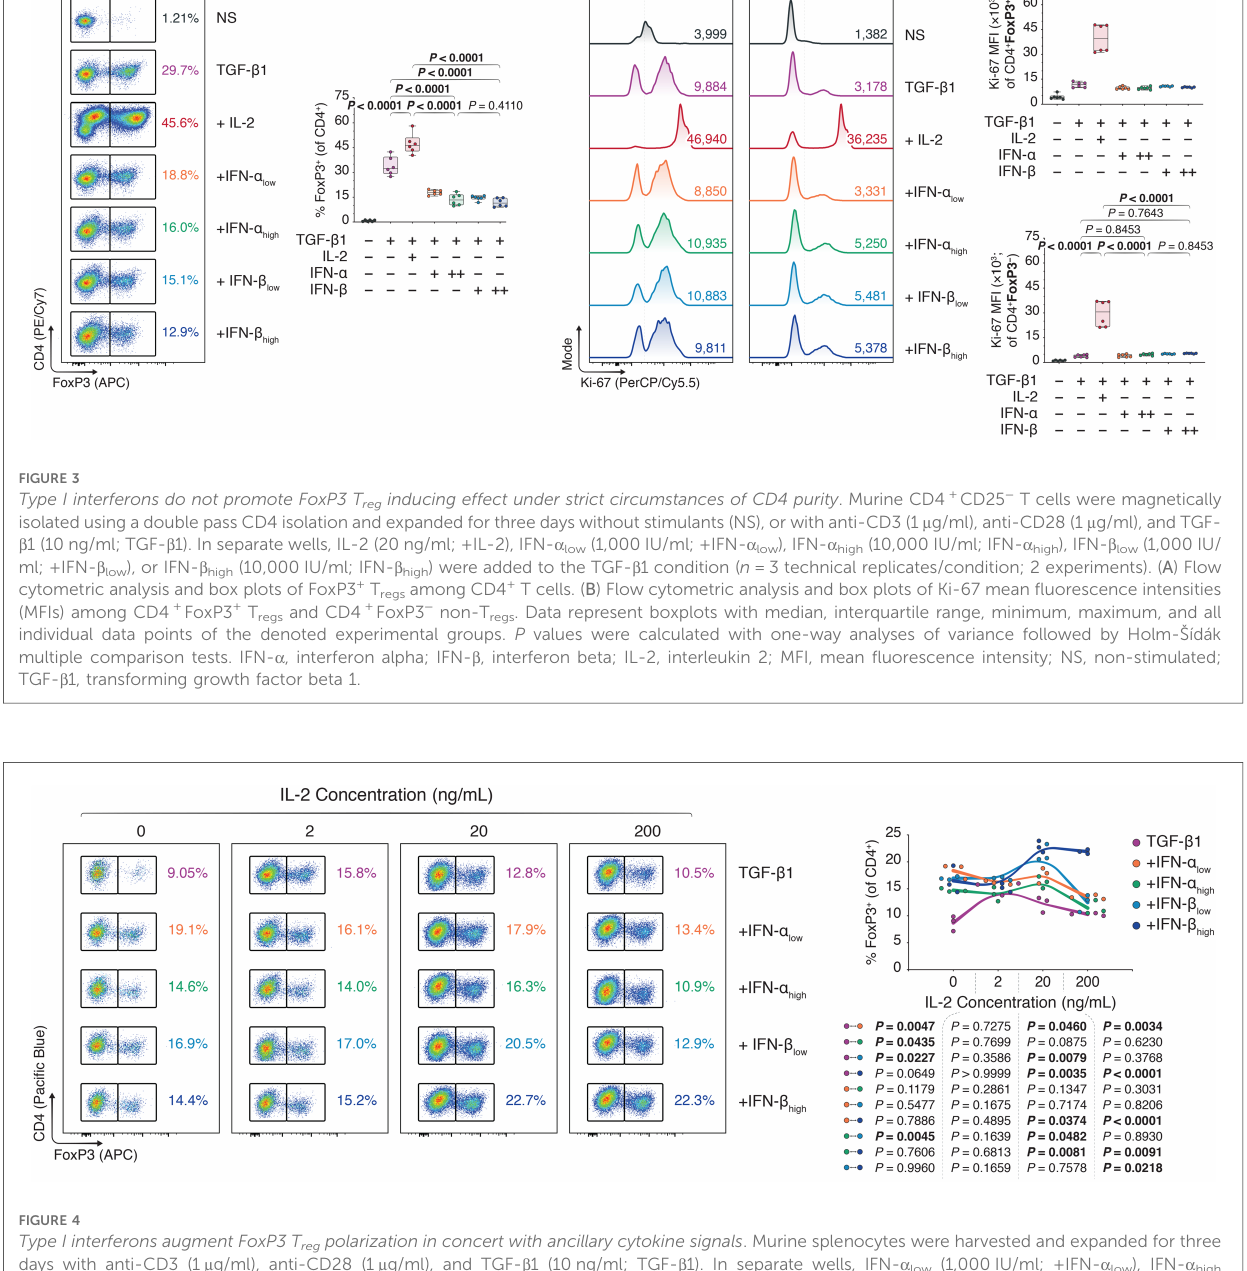
induction among type I IFN-treated and -untreated splenocytes, at 20 and 200 ng/ml of IL-2, there were marked differences in the CD4 + FoxP3 + frequency between TGF- β 1-treated splenocytes with and without type I IFNs ( Figure 4 ).